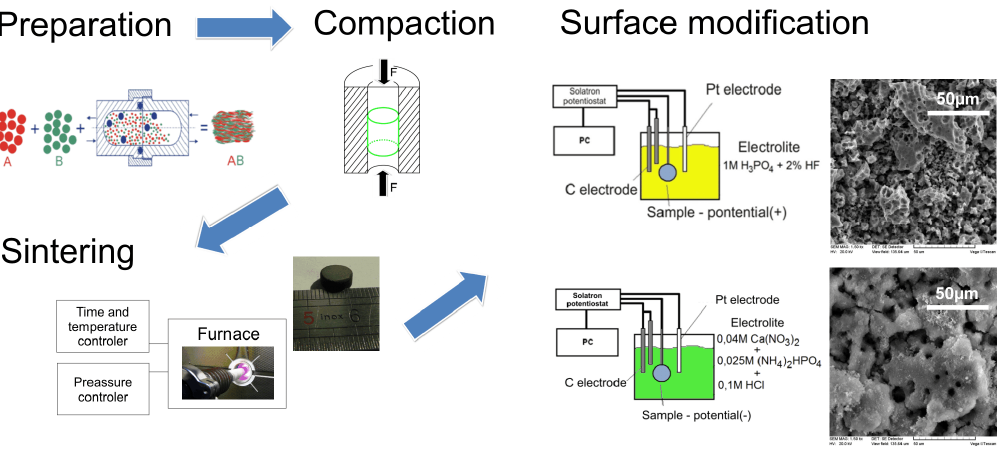
Figure 1. Experimental setup Ti23Mo- x wt % 45S5 Bioglass nanocomposite synthesis and electrochemical Experimental setup Ti23Mo- x wt % 45S5 Bioglass nanocomposite synthesis and treatment procedure. electrochemical treatment procedure.